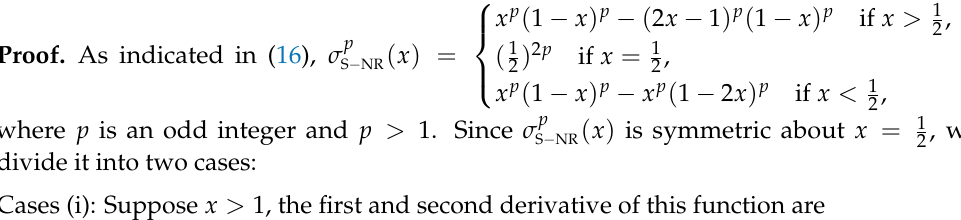
with different values of p S − NR